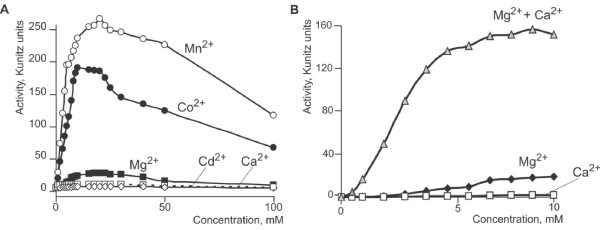
A: Relationship between divalent cation concentration and DSN activity. The incubation mixtures (50 mM Tris-HCl, pH 7.15) contained calf thymus DNA (50 μg/ml), 8 units/ml DSN and different concentrations of MnCl2, CoCl2, MgCl2, CdCl2, CaCl2. B: Relationship between DSN activity and concentration of magnesium chloride, calcium chloride and their mixture. The incubation mixtures (50 mM Tris-HCl, pH 7.15) contained calf thymus DNA (50 μg/ml), 8 units/ml DSN and different concentrations of MgCl2, CaCl2, and mixtures of MgCl2 and CaCl2.